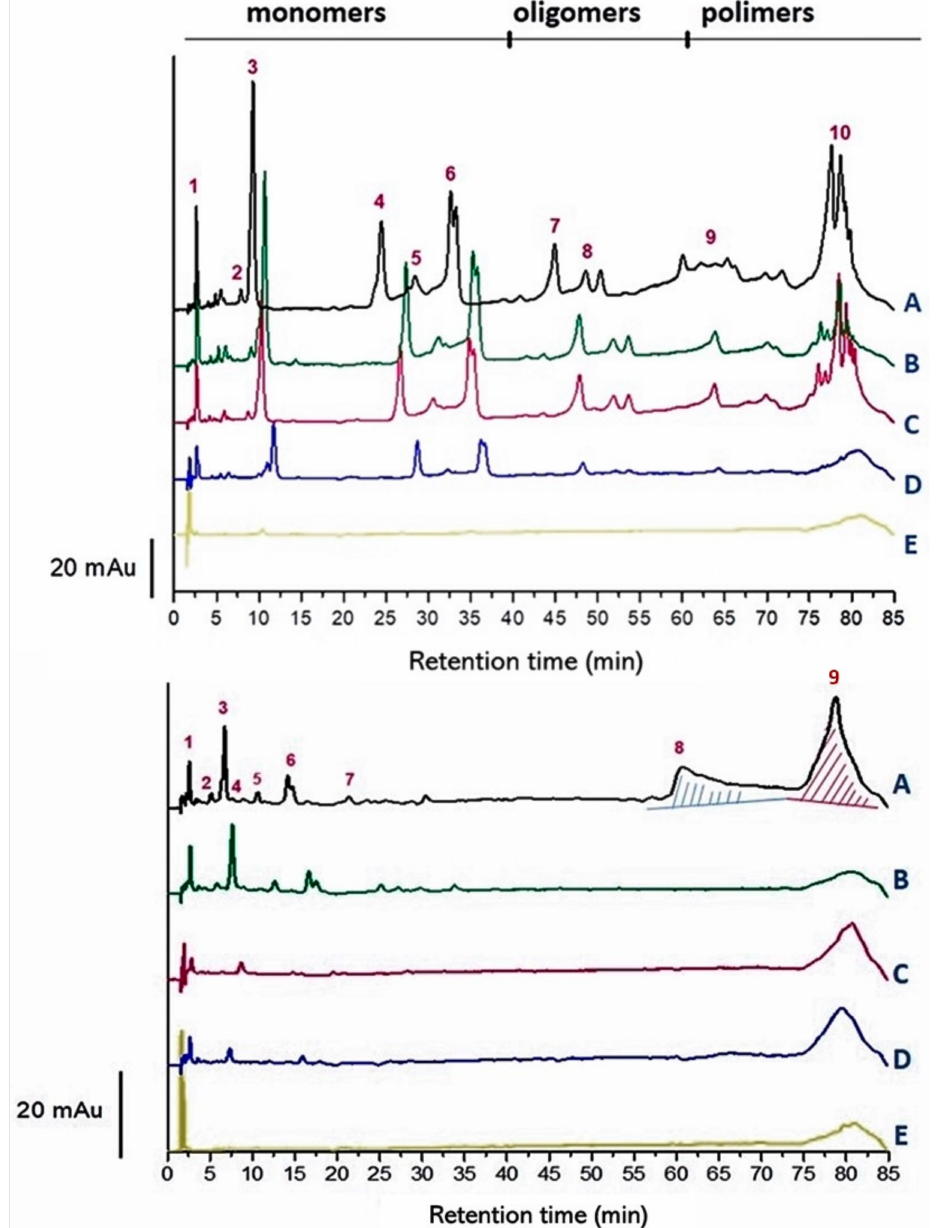
Figure 2. HPLC profile at 280 nm of fining trials in model wine solutions with gallotannin ( top ) and grape seed proanthocyanidin ( bottom ) at 0.6 g/L. Legend of fining agents: (A) control; (B) patatin (PP) at 1 g/L; (C) BSA at 1 g/L; (D) PVPP at 1 g/L; (E) MCP at